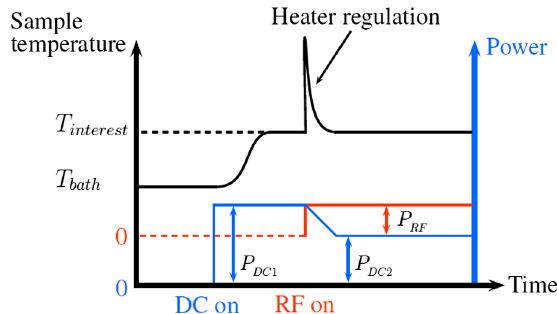
FIG. 1. Illustration of the CERN-QPR [3] (left), technical drawing [2] (right).